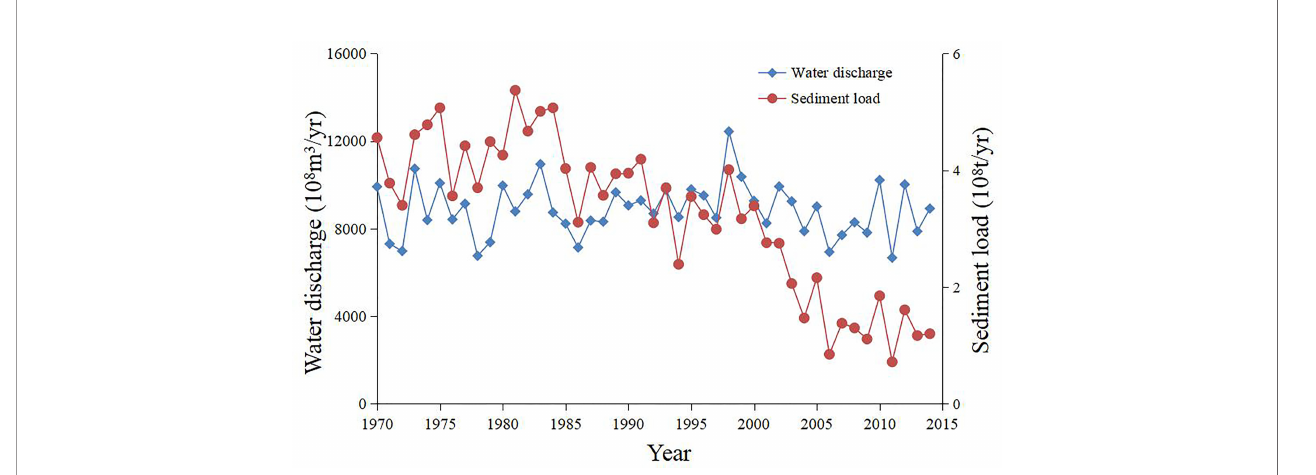
FIGURE 6 | Datong station into the sea and sand long-term changes in